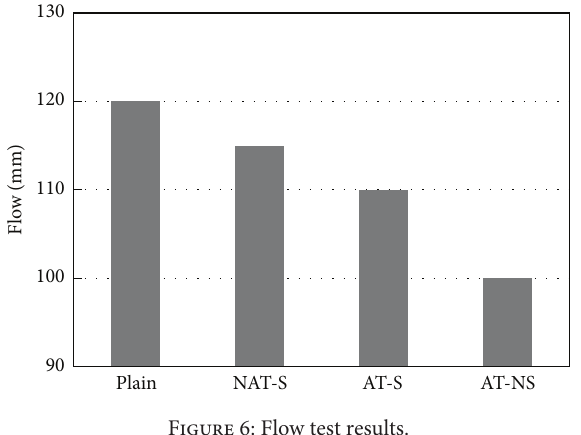
Figure 6: Flow test